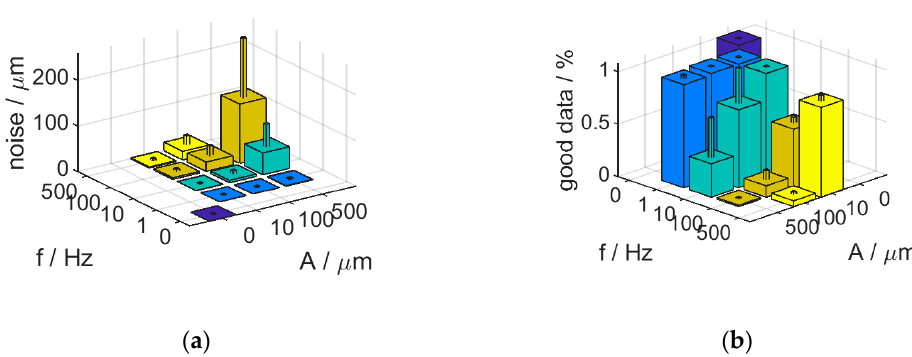
Figure 11. The effect of vibrating sample on noise ( a ) and data quality ( b ) for various vibration frequencies and amplitudes. The standard deviation is shown by the single-sided positive error bars.